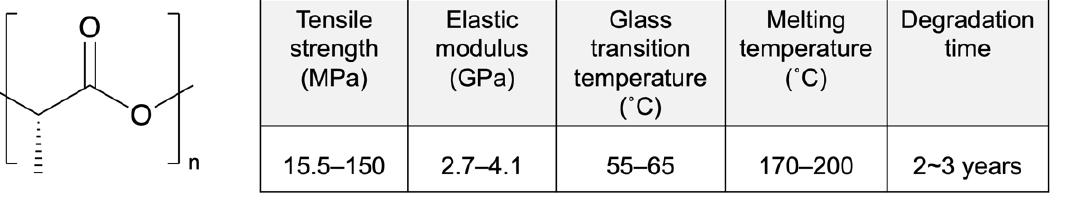
Figure 2. Structure and properties of poly-L-lactic acid (PLLA). Reprinted with permission from [31], published by Elsevier, 2016.